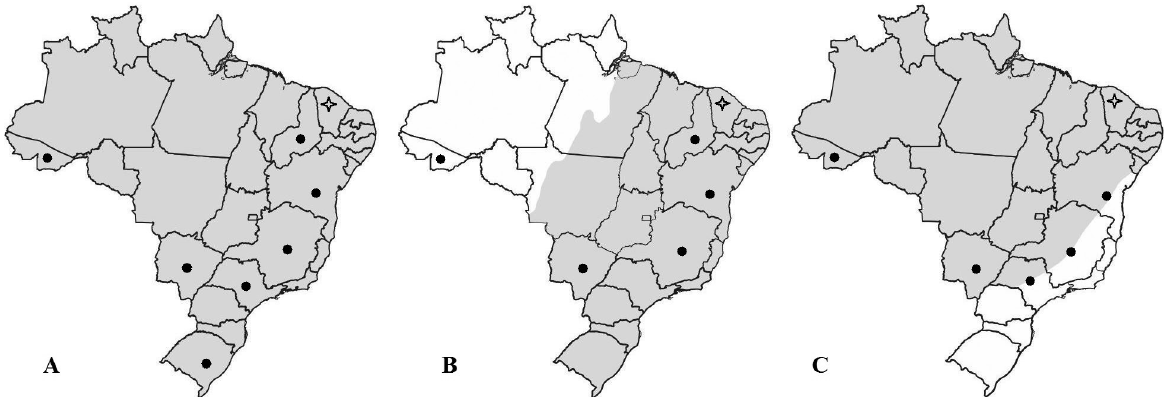
Figure 5 - Maps showing the current area of distribution of the species Dasypus novemcinctus (A), Euphractus sexcinctus (B) and Cabassous unicinctus (C) in Brazil (Modified from Eisenberg and Redford 1999). In evidence the fossil occurrences according to Ameghino (1907), Paula Couto (1973, 1979, 1983), Guérin et al. (1996), Faure et al. (1999), Salles et al. (2006), Oliveira and Pereira (2009) and Castro et al. (2013), and the presence of these genera in the State of Ceará as a contribution of this